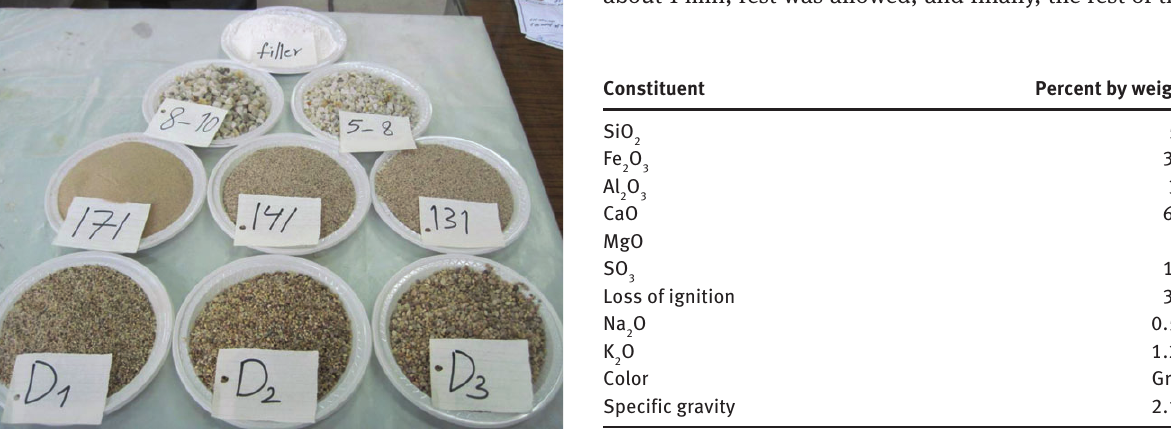
Table 4 Chemical and physical properties fly